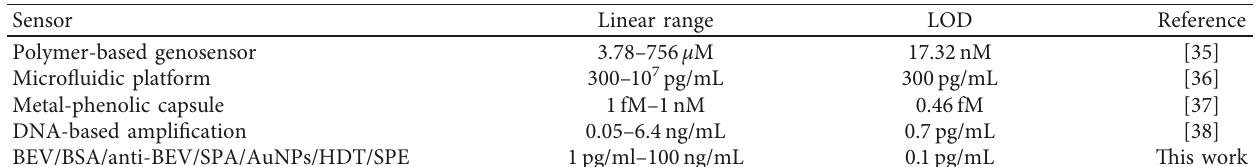
Figure 6: (a) EIS of fabricated sensor towards 1 pg/mL, 10pg/mL, 100 pg/mL, 1ng/mL, 10ng/mL, and 100ng/mL of EBV (0.1M PBS). (b) Corresponding plots of concentration of EBV and Δ Table 1: Comparison of different electrochemical sensors for EBV detection.